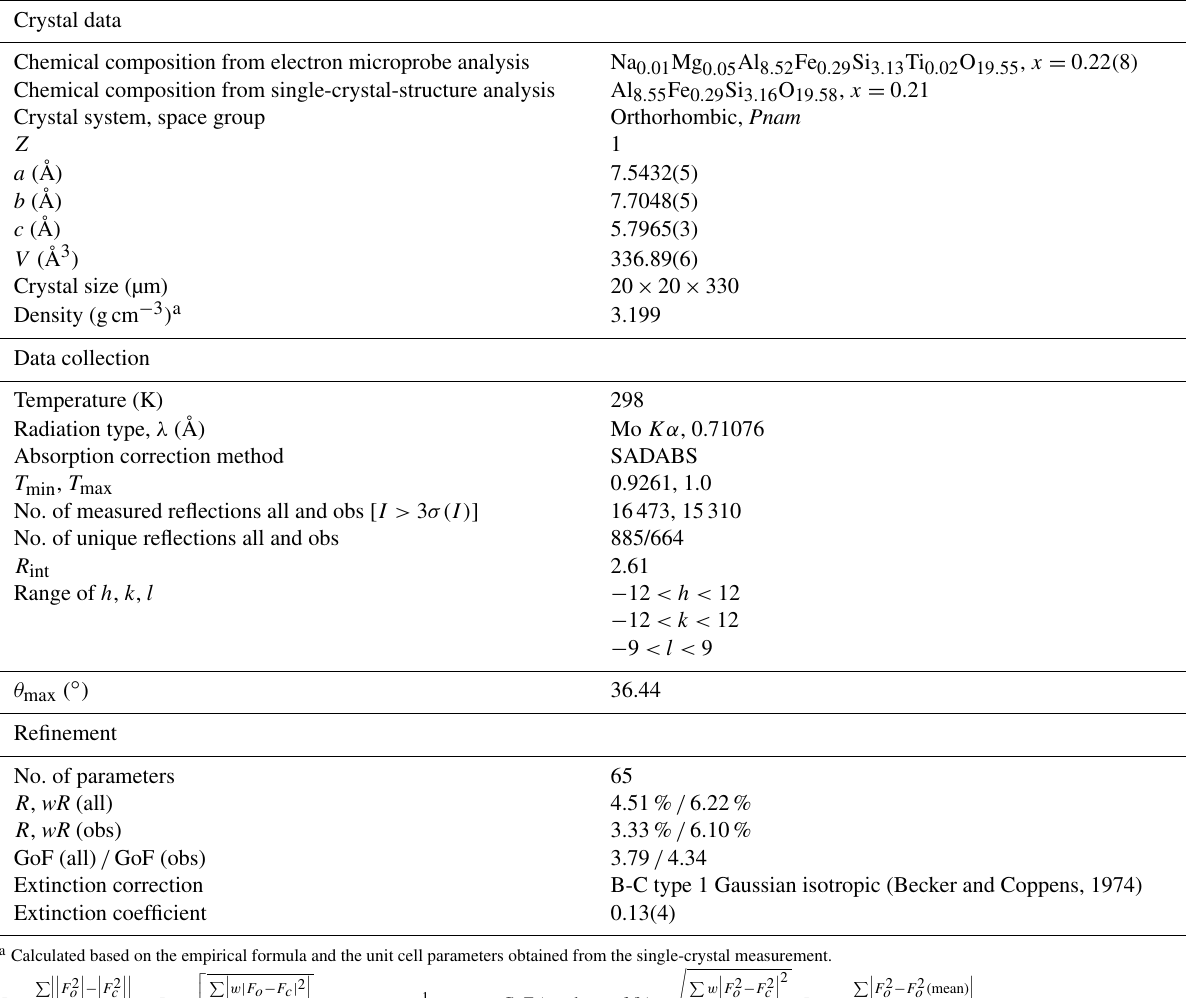
Table 1. Crystal data, data collection parameters and structure refinement details for mullite-2 c . Crystal